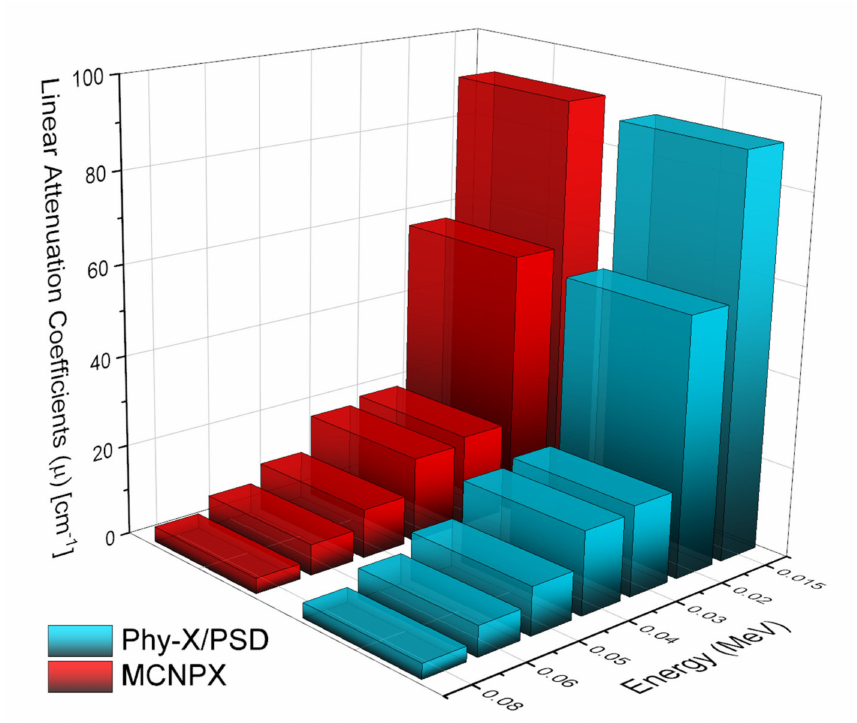
Figure 2. Comparison of linear attenuation coefficient ( µ ) values for AL0.0 sample obtained from MCNPX and Phy-X/PSD at low gamma-ray energy